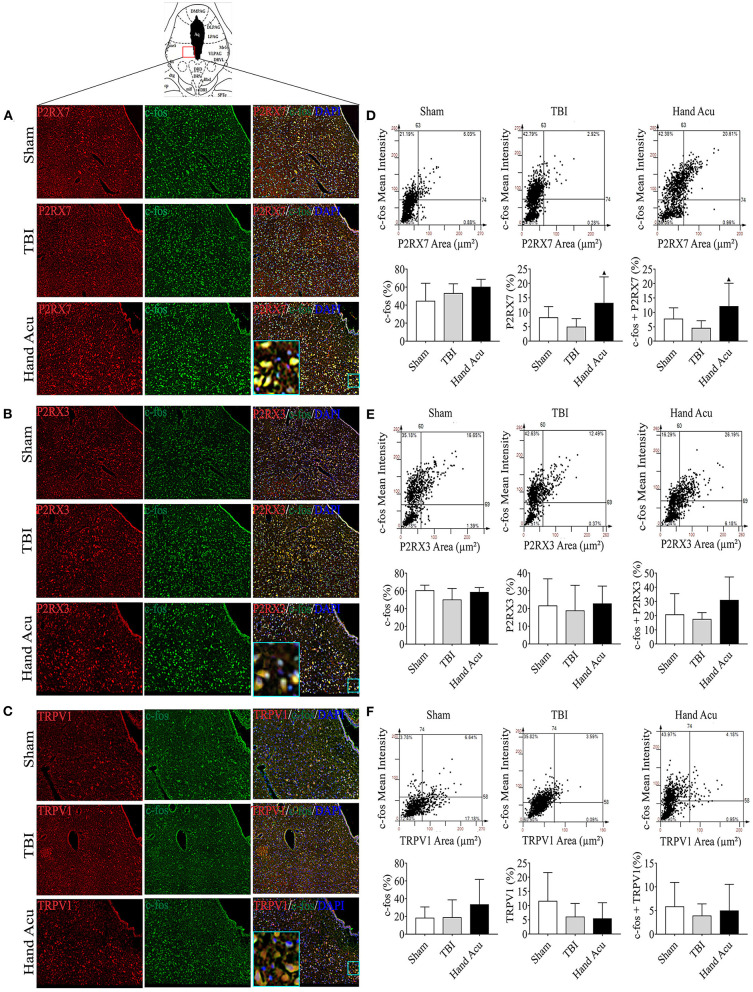
HTWP acupuncture activates P2RX7 neurons in the ventral periaqueductal gray. (A–C) Confocal and co-localization analyses of P2RX7, P2RX3, and TRPV1 with c-fos and DAPI. (D–F) HistoFAXS tissue analysis of c-fos staining mean intensity vs. area (μm2), and quantitative analysis by image scanning of co-localization of c-fos with P2RX7, P2RX3, and TRPV1 in the left vPAG of sham and TBI rats treated with or without HTWP acupuncture (hand Acu) (n = 3–4/group; one-way ANOVA). Error bars represent mean + SEM; ▴P < 0.05 vs. TBI.